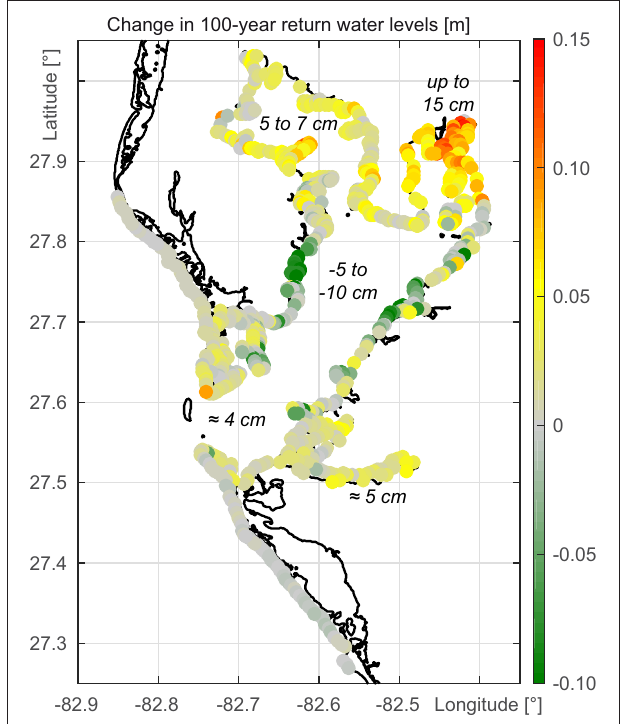
FIGURE 6 | Change in 25-year return water levels for available grid points along the Tampa Bay and Gulf coastline.